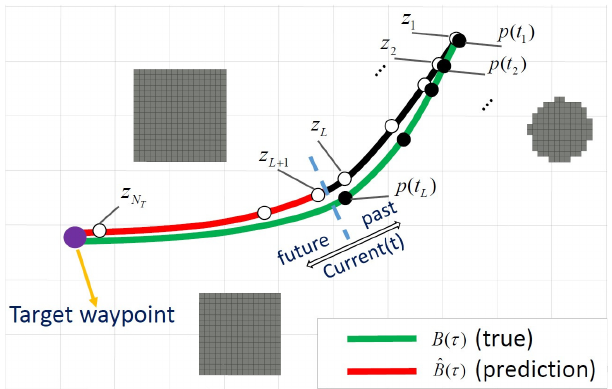
Figure 3. The prediction of the target